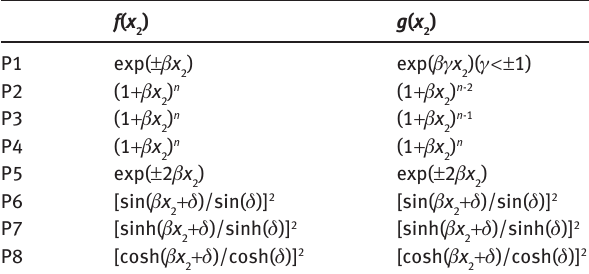
Table 2: Some special inhomogeneity functions.